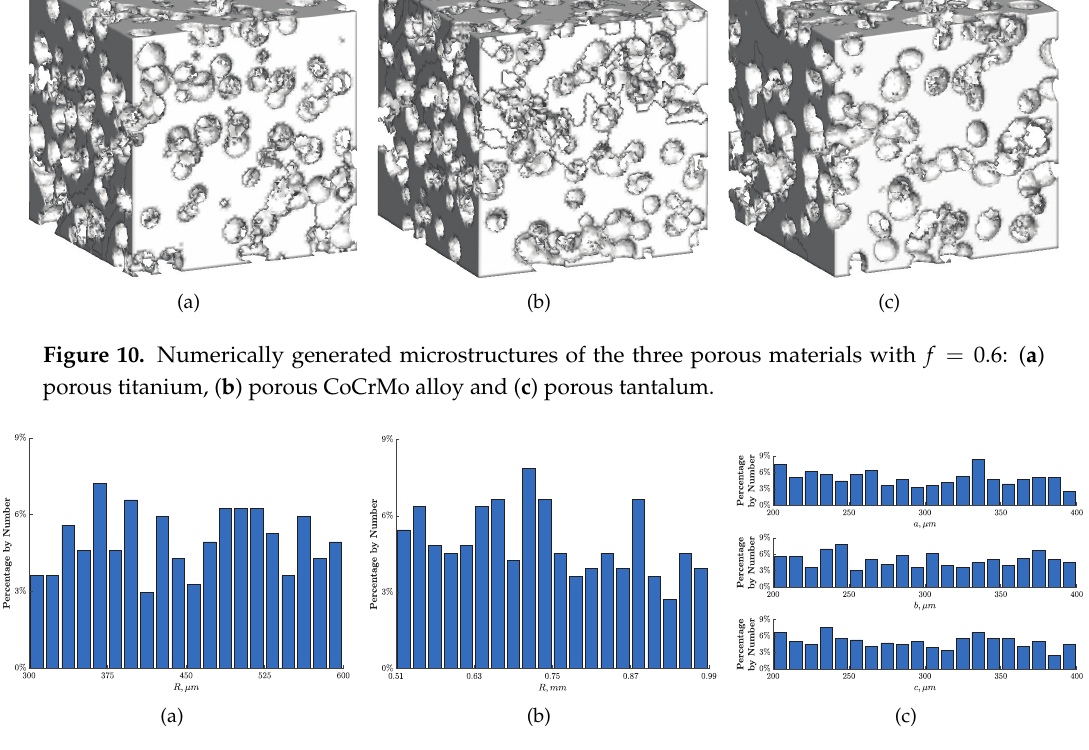
Figure 11. Statistical morphological parameters of pores constituting the porous microstructures in Figure 10: ( a ) porous titanium, ( b ) porous CoCrMo alloy and ( c ) porous